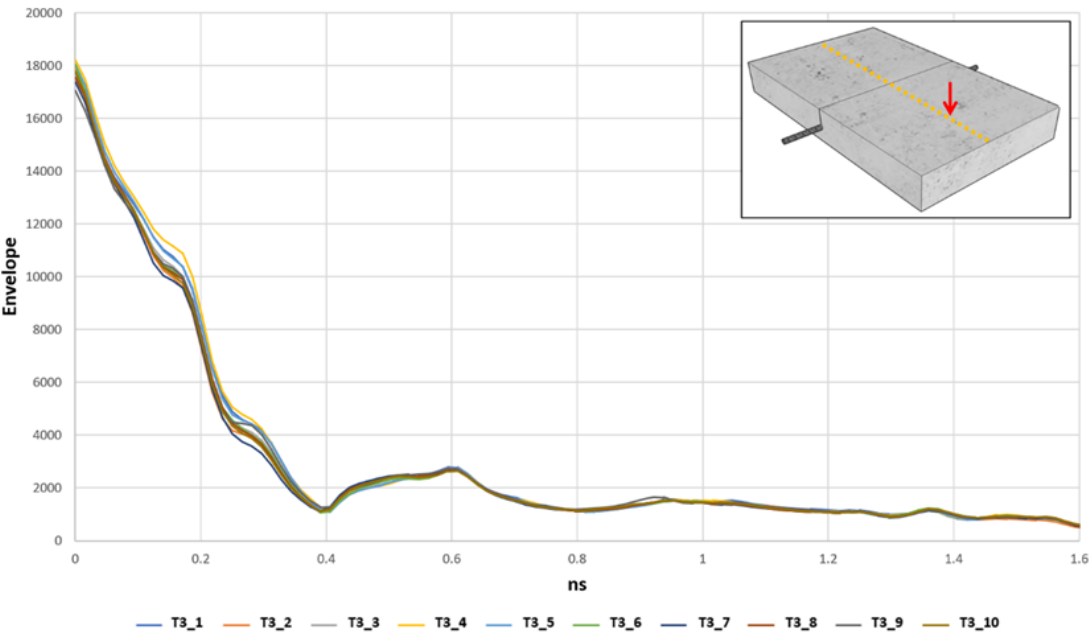
Figure 12. Envelope A-scan was acquired on sample “B” during the accelerated corrosion test. The trace shown is coming from the radargram n°29, 10 cm before the steel rebar. From the graph, we can see that there were no changes in the envelope A-scan trace during the corrosion